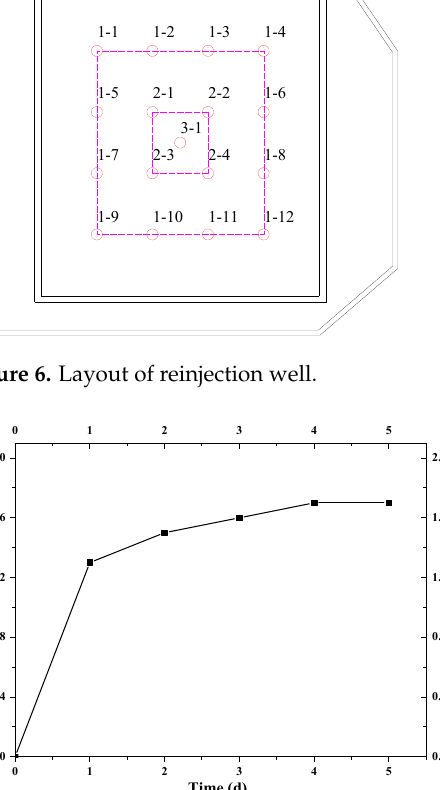
Figure 6. Layout of reinjection well.